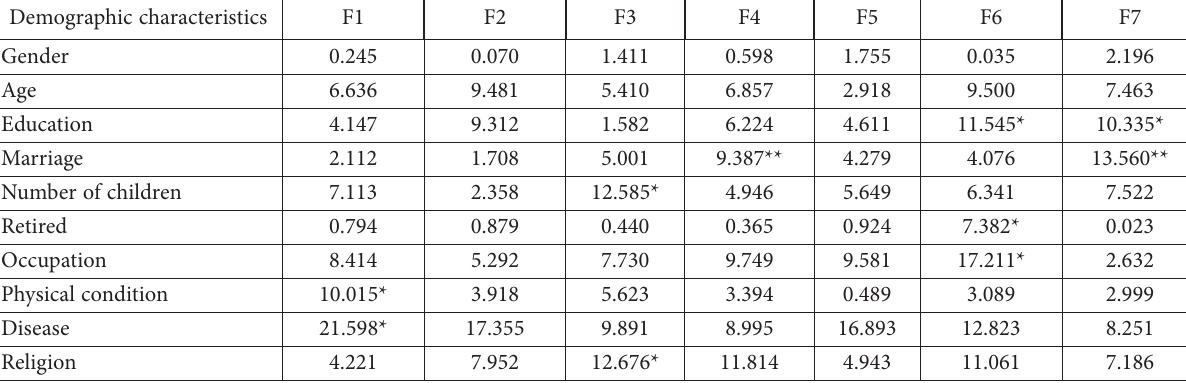
Table 6. Chi-square test results between demographic characteristics and the demand clusters of each service demand aspect Demographic characteristics